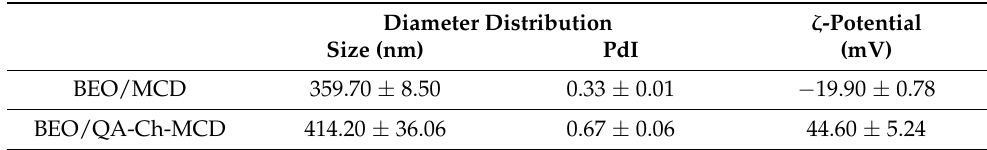
Table 2. Diameter distribution and ζ -potential values of BEO/MCD and BEO/QA-Ch-MCD in aqueous solutions. Mean ± SD, n =